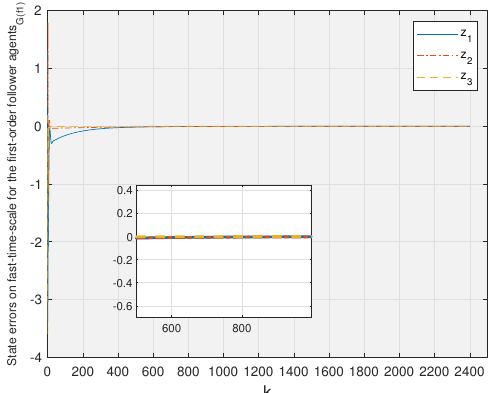
Figure 5. State errors on fast-time scale for the first-order follower agents.